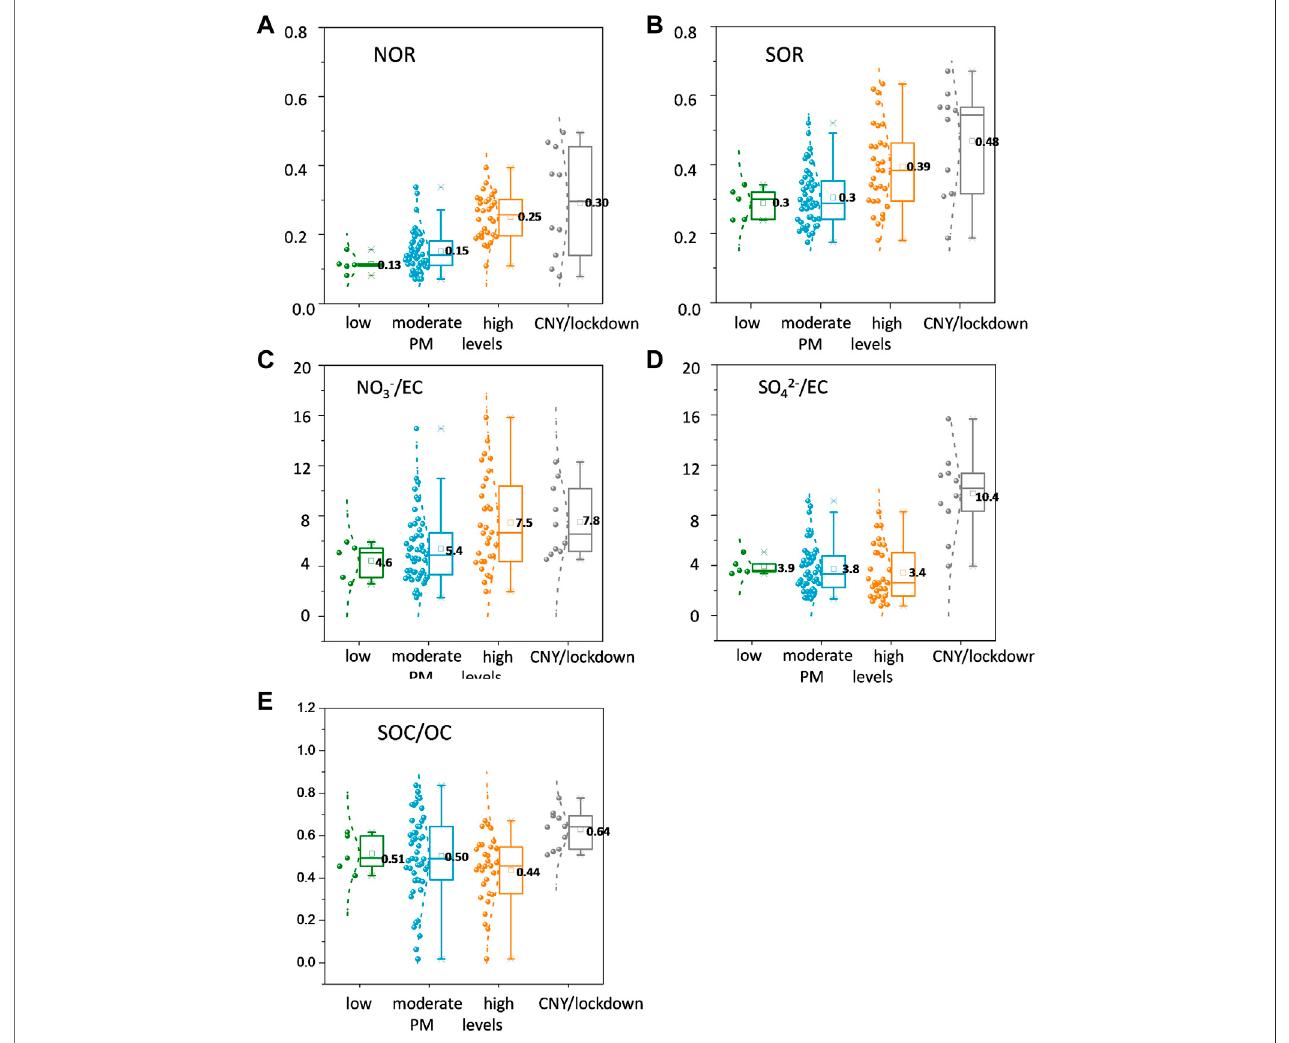
FIGURE 5 | Box and whisker plots of variation of (A) NOR, (B) SOR, (C) NO 3 − /EC, (D) SO 42- /EC and (E) SOC/OC in different phases. The mean (the small box), median (horizontal line), 25th and 75th percentiles (lower and upper box), and the 10th and 90th percentiles (lower and upper whiskers) are shown in the plots.